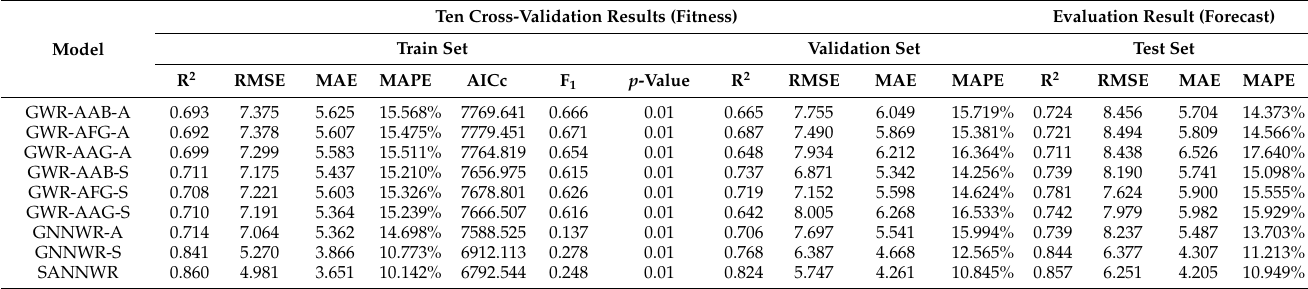
Table 6. Average value of the ten cross-validation results of the training set. Ten Cross-Validation Results (Fitness) Evaluation Result Model